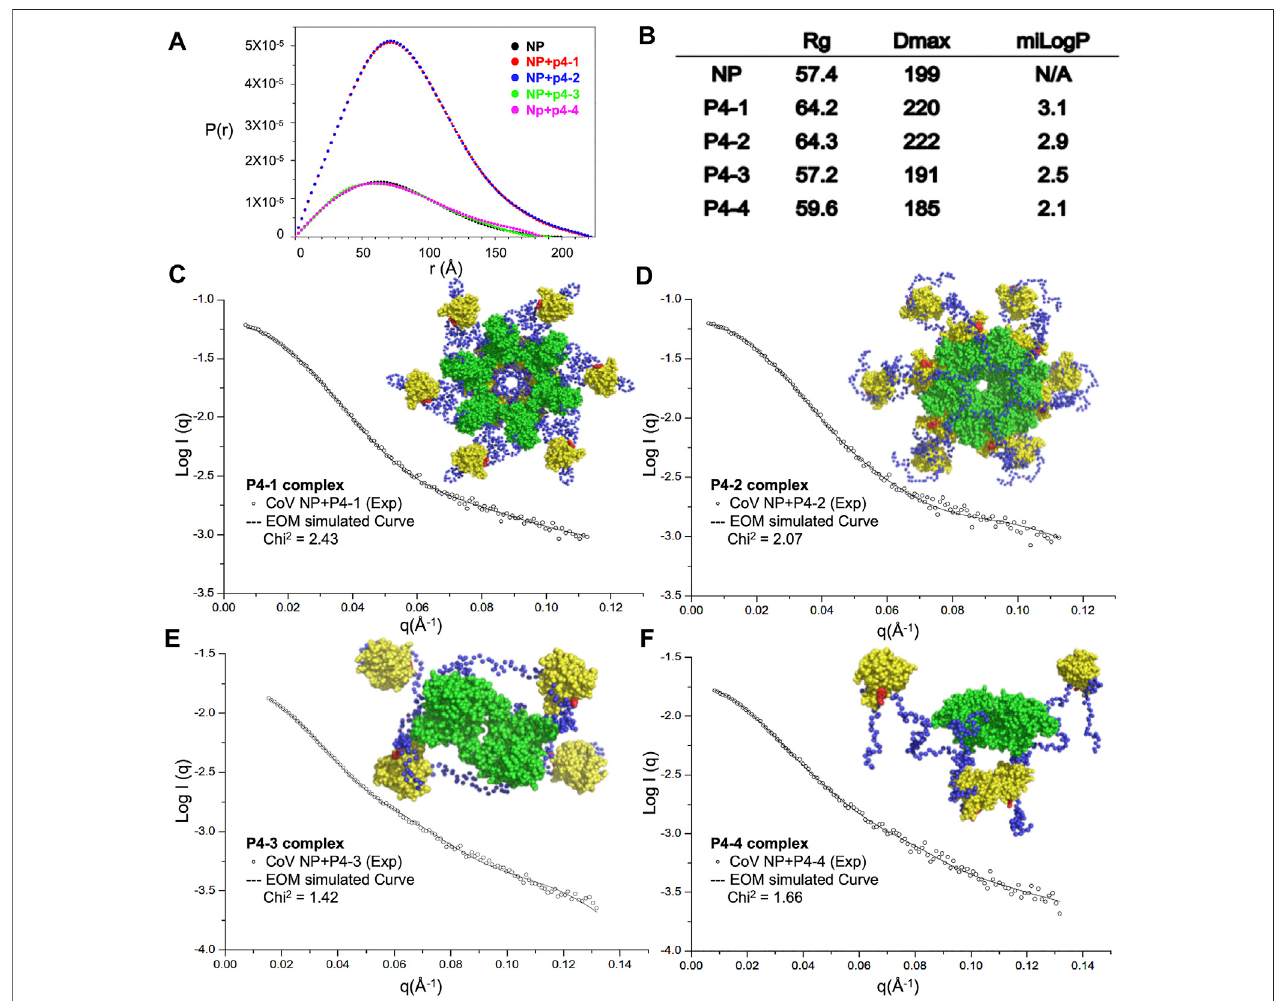
FIGURE 3 | Increased hydrophobicity of P4 ligand is correlated with the aggregation tendency of CoV N protein. (A) SAXS analysis of full-length CoV N protein complexed with P4 derivative compounds. Normalized results from GNOM are described with pairwise distance distribution P(r) and maximum distance. (B) The calculatedvaluesofRg,DmaxandmiLogPofeachcomplex. (C – F) (left)Scatteringpro fi lesofP4-1complex (C) ,P4-2complex (D) ,P4-3complex (E) ,andP4-4complex (F) and normalization fi tting with GNOM (dashed lines). (Right) Representative models of P4-1 complex (C) , P4-2 complex (D) , P4-3 complex (E) , and P4-4 complex (F) generated by CRYSOL simulations of SAXS data. NTD, CTD, linker and P4s are shown as yellow, green, blue and red, respectively.